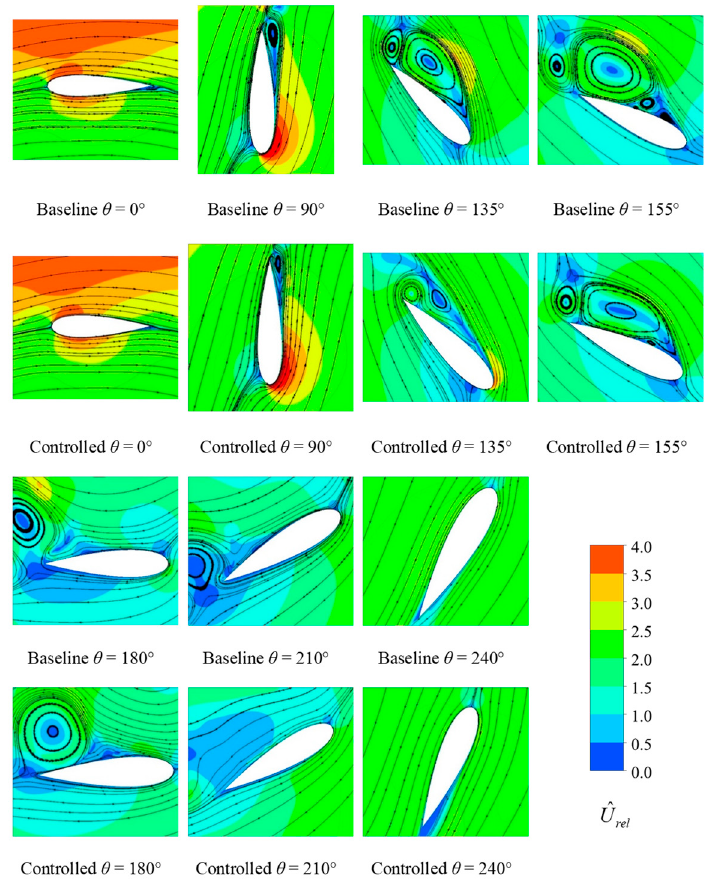
Figure 22. Relative streamlines and relative velocity contours with azimuth for baseline and plasma controlled case (actuator at 30% c ).